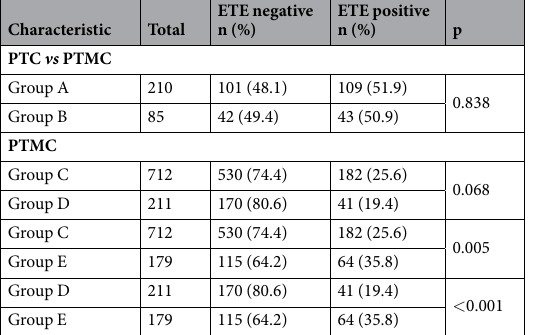
Table 3. Differences in lymph node metastasis between the different extrathyroid extension groups. ETE: extrathyroidal extension; Group A: PTC, unifocal with diameter > 1 cm and ≤ 2 cm; Group B: PTMC multifocal with total tumor diameter (TTD) > 1 cm and ≤ 2 cm; Group C: PTMC unifocal with diameter ≤ 1 cm; Group D: PTMC multifocal with TTD ≤ 1 cm; Group E: PTMC multifocal with TTD > 1